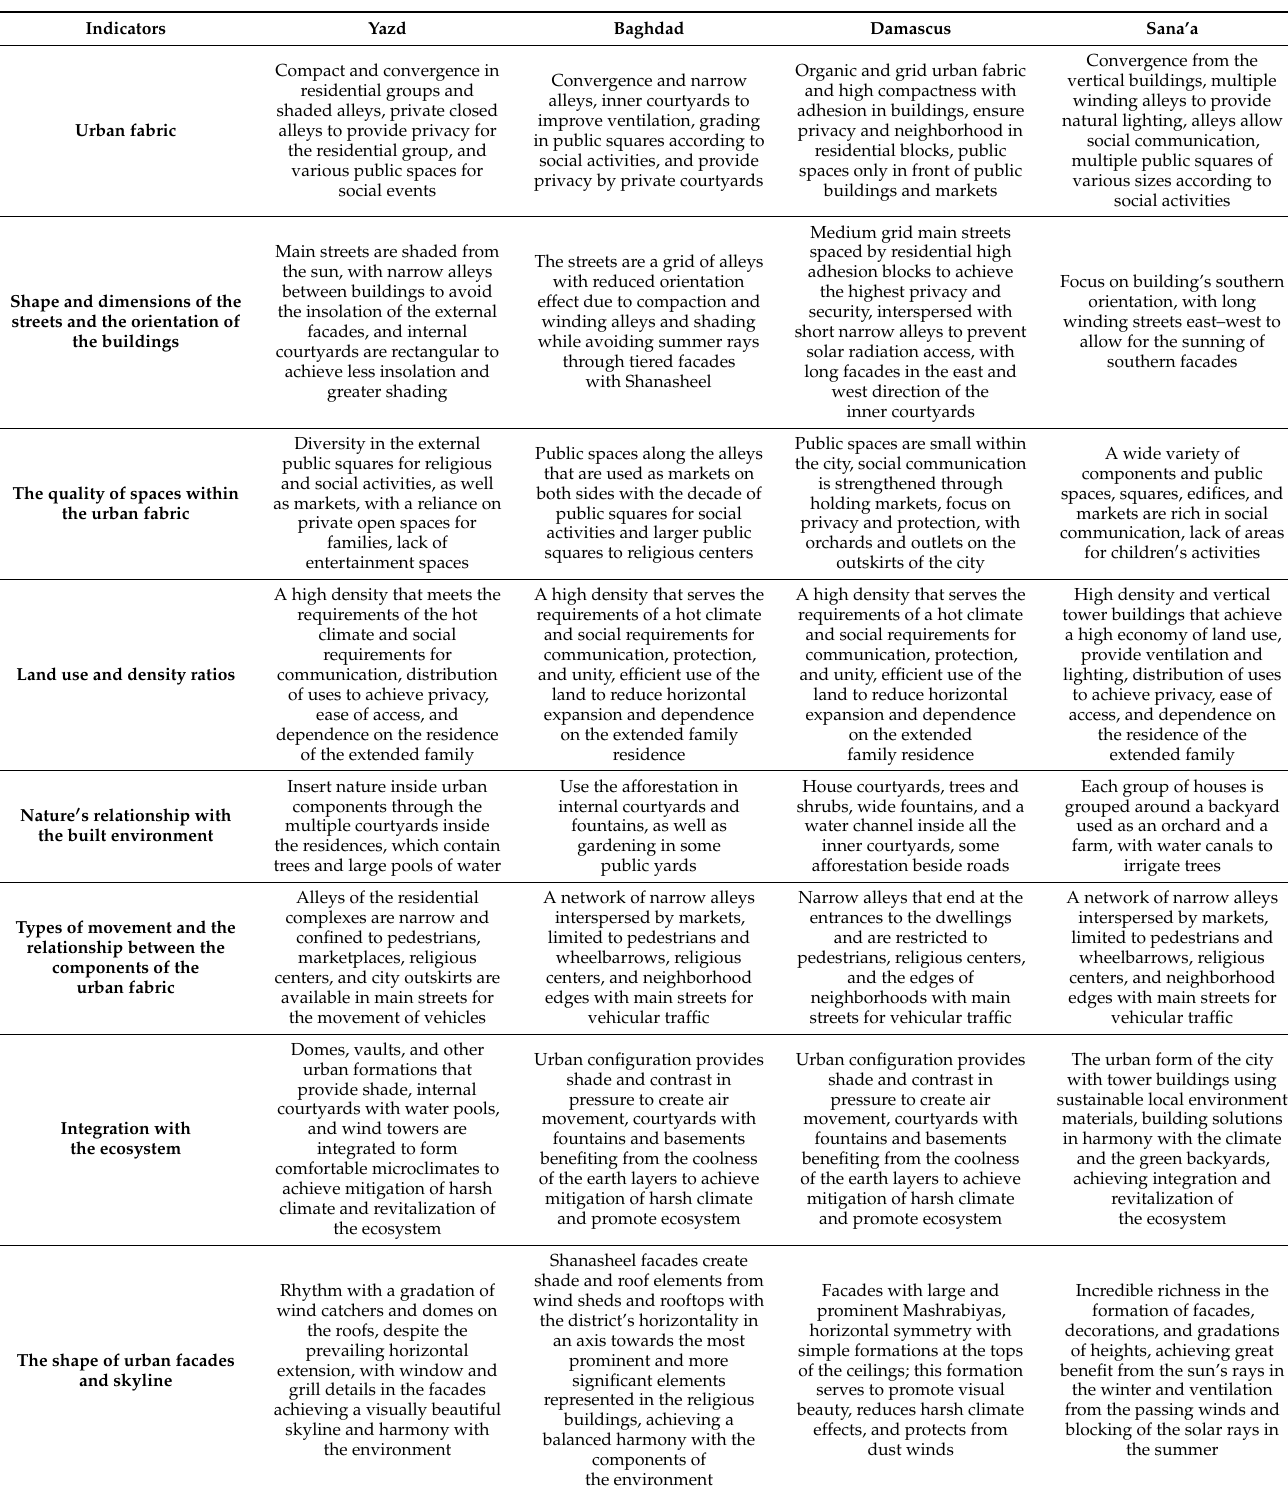
Table 1. Discussion and analysis of the achievement of climate adaptation strategies for the study cities, in terms of the requirements of climatic and social